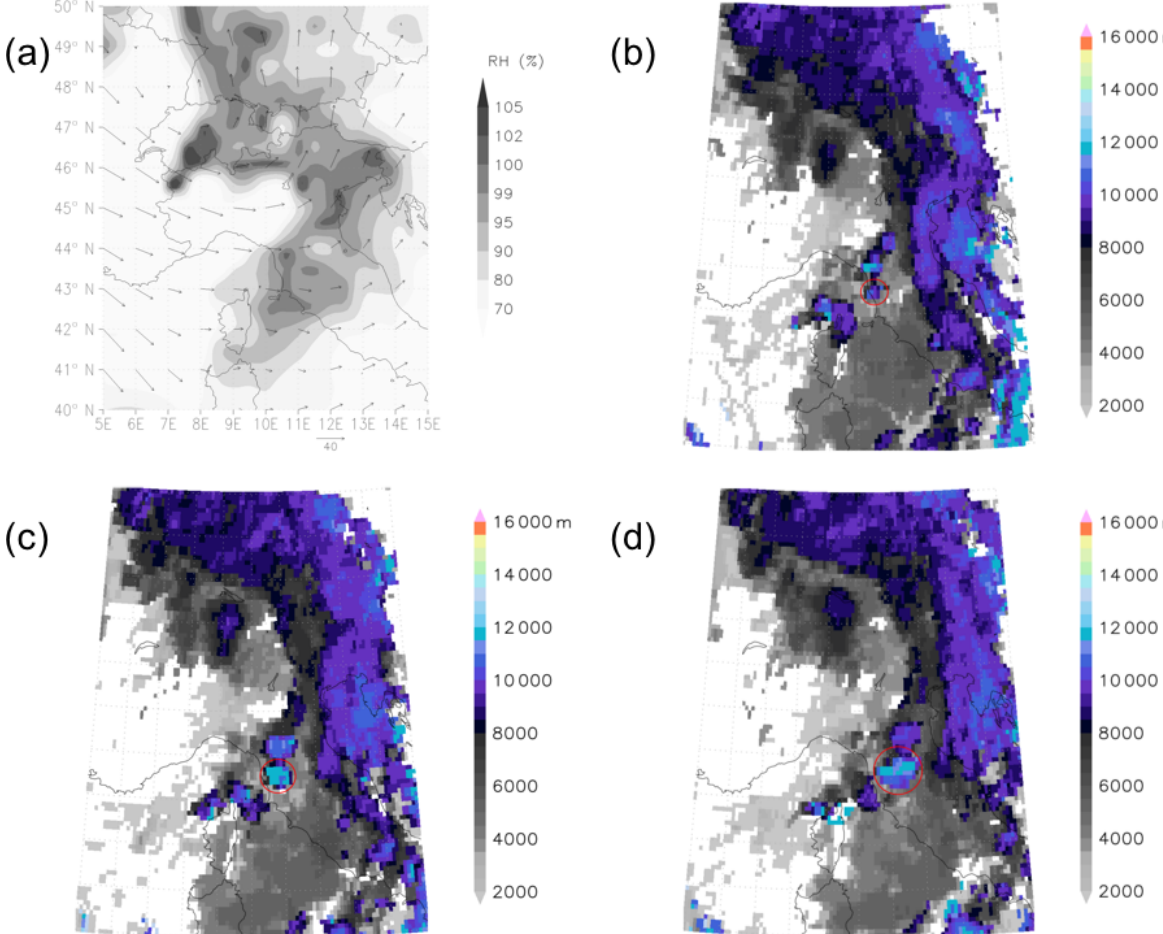
Figure 18. Panel (a) : relative humidity (shaded contours) at 700hPa and mean storm motion (vectors) from GFS analyses on 4 October 2015 at 06:00UTC. Panels (b–d) : cloud top height from MSG data on 4 October 2015 at 04:30 (b) , 05:15 (c) , and 06:00UTC (d) . Red circles indicate the thunderstorm position and